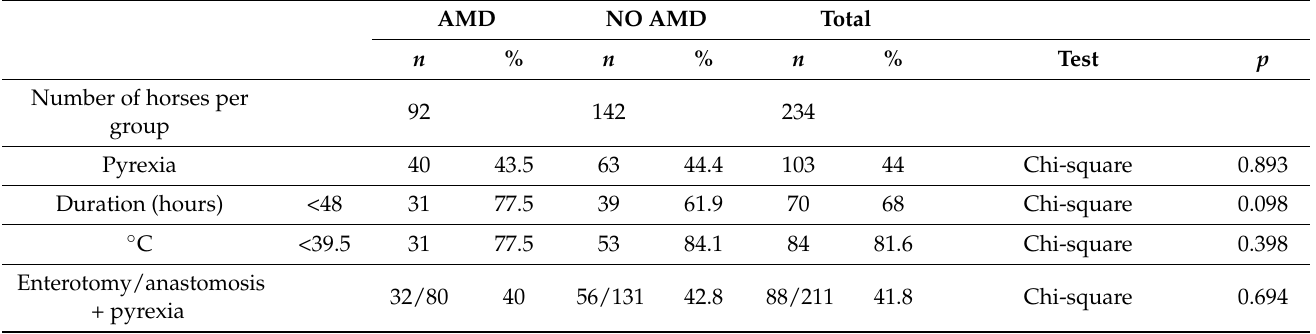
Table 4. Data about the onset of pyrexia in the postoperative